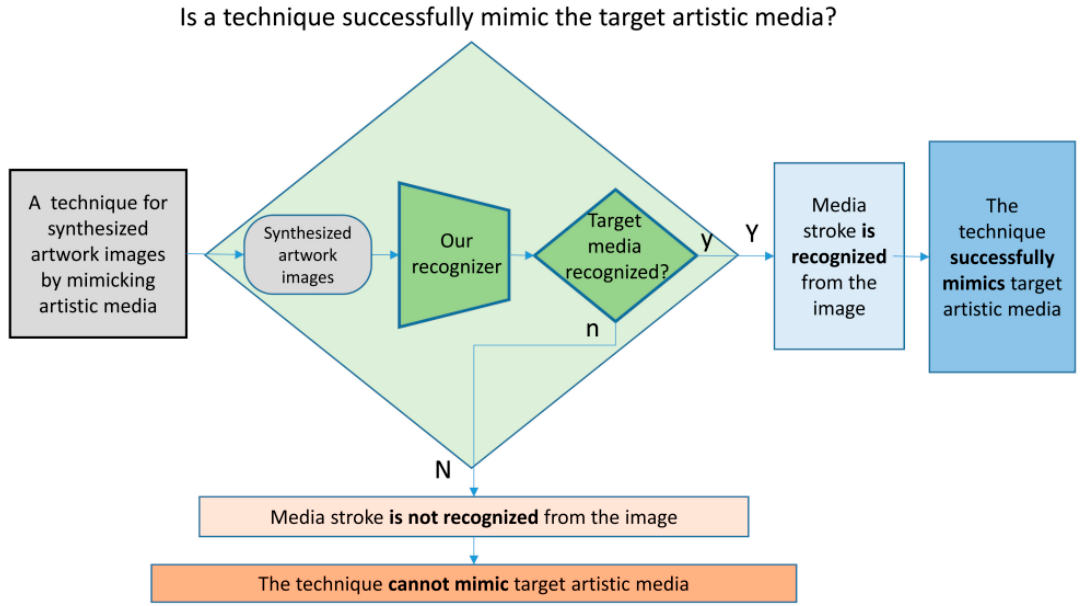
Figure 13. The process of evaluation guideline for synthesized artwork images. A technique that generates synthesized artwork images by mimicking artistic media is evaluated to be successful, if our recognizer can recognize the target media from their result images.